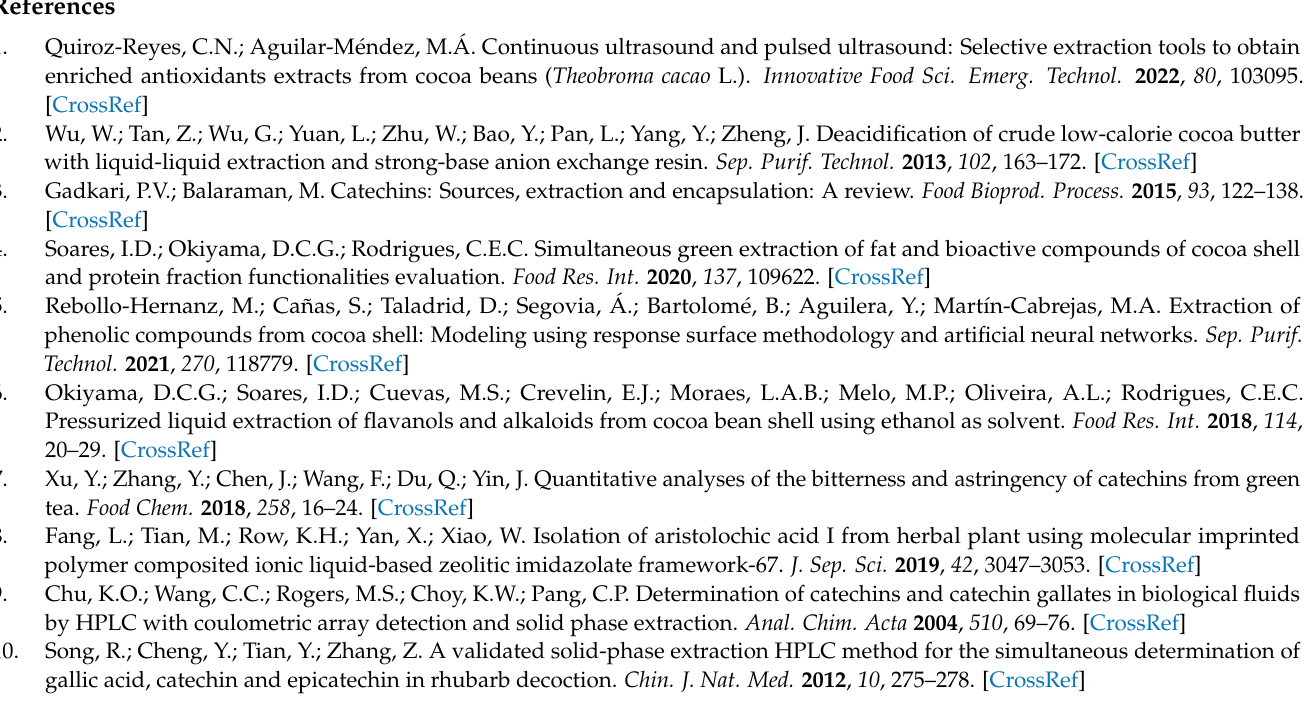
Figure S2: FT-IR of ZIF8, Sil, Sil@ZIF8 and one of Sil@ZIF8@IL-IL; Figure S3: TGA analysis of ZIF8, Sil, Sil@ZIF8 and one of Sil@ZIF8@IL-IL; Figure S4: The adsorption efficiencies of four Sil@ZIF8@HIM-IL sorbents; Figure S5: The relationships between C 0 and Q e of (+)-catechin on four Sil@ZIF8@BIM- IL sorbents at 10, 20, 30 and 40 ◦ C; Figure S6: The pH effect of (+)-catechin aqueous solution on adsorption